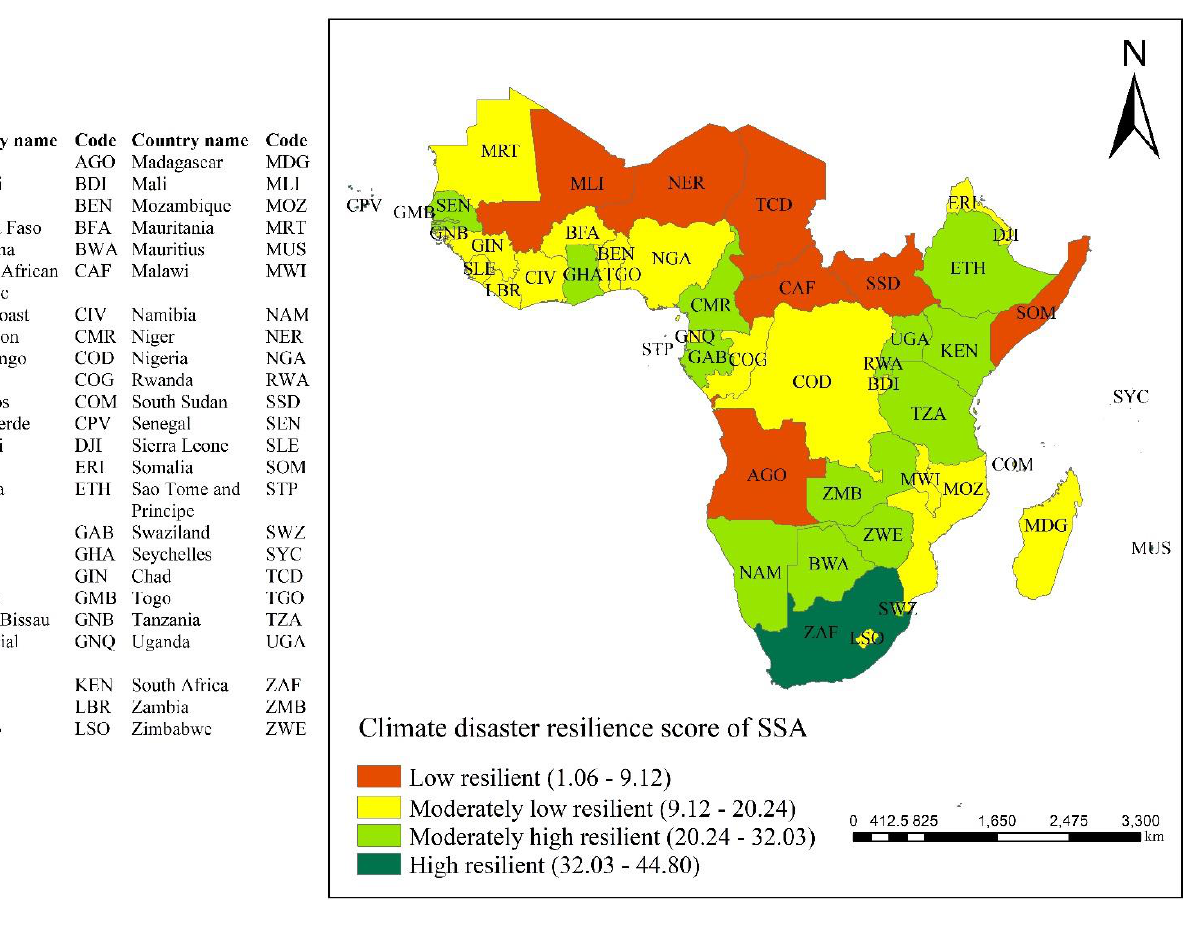
Figure 3. Spatial characteristic of composite national climate resilience index (CNCRI) scores of SSA. Climatically, the CNCRI score indicates that most of the low resilient countries are located in the desert and semidesert zone in the tropical region of SSA. the moderately low and high resilient scores were dominated by countries in the grassland land zone in the tropical and subtropical regions. Countries such as Ghana and Gabon, located in the rainforest zone, and South Africa in the humid subtropical zone are the most resilient in many of the individual resilience dimensions. The top five highest resilient countries of the overall rank of the BNCRI index score are Mauritius (1), Seychelles (2), Cape Verde (3), South Africa (4), and Gabon (5). While the vulnerable countries of the CNCRI index score were Mali (44), Central African Republic (45), Chad (46), South Sudan (47) and Somalia (48) (see Table